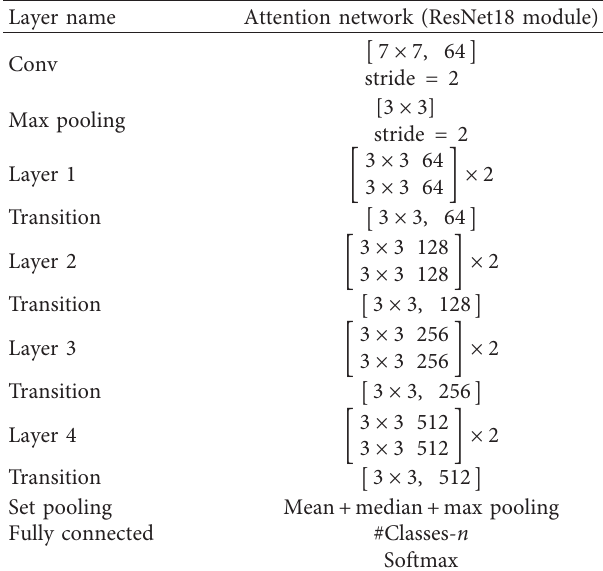
Table 2: Network configuration of first